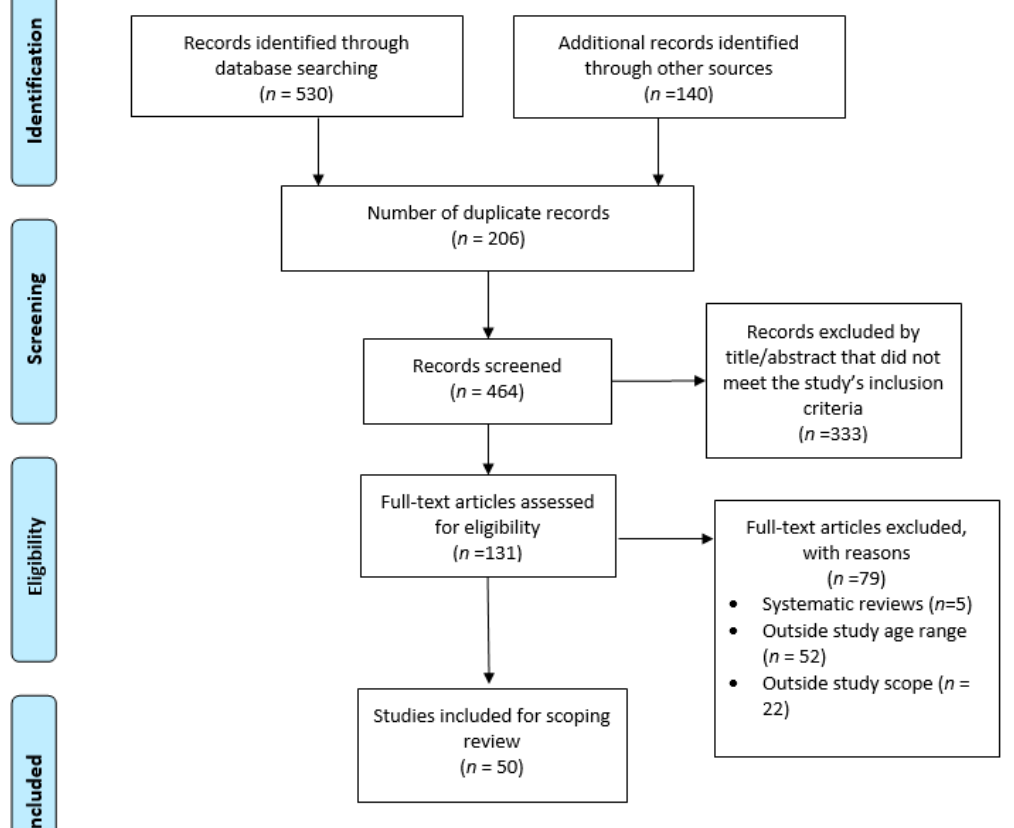
Figure 1. PRISMA flow diagram of included articles for scoping review.